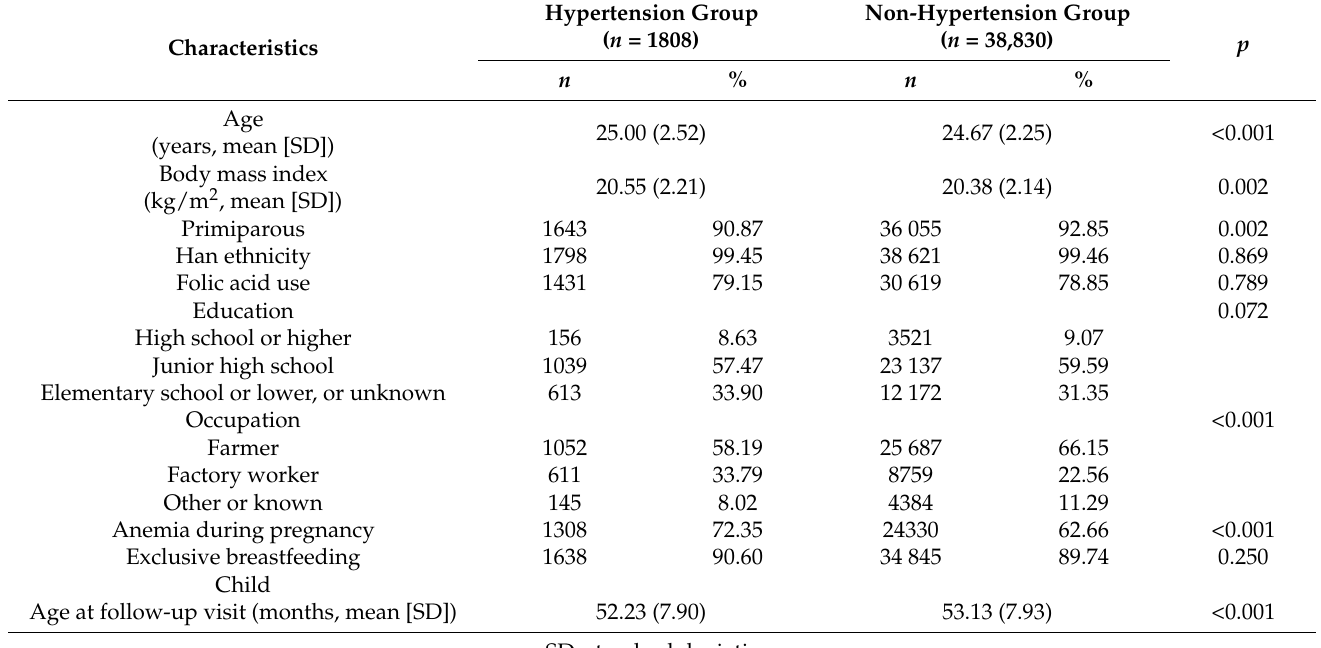
Table 1. Baseline characteristics of women according to preconception hypertension in China.